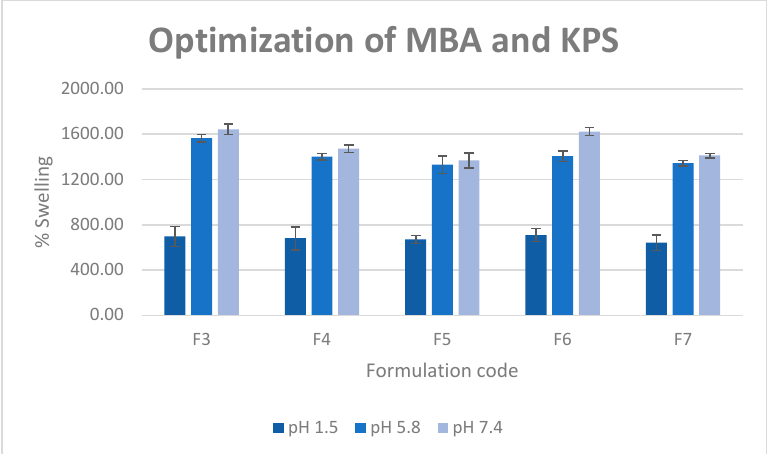
Figure 3. Swelling behaviour of hydrogels contains different amount of MBA and KPS at various phosphate buffer pH (1.5, 5.8, 7.4).